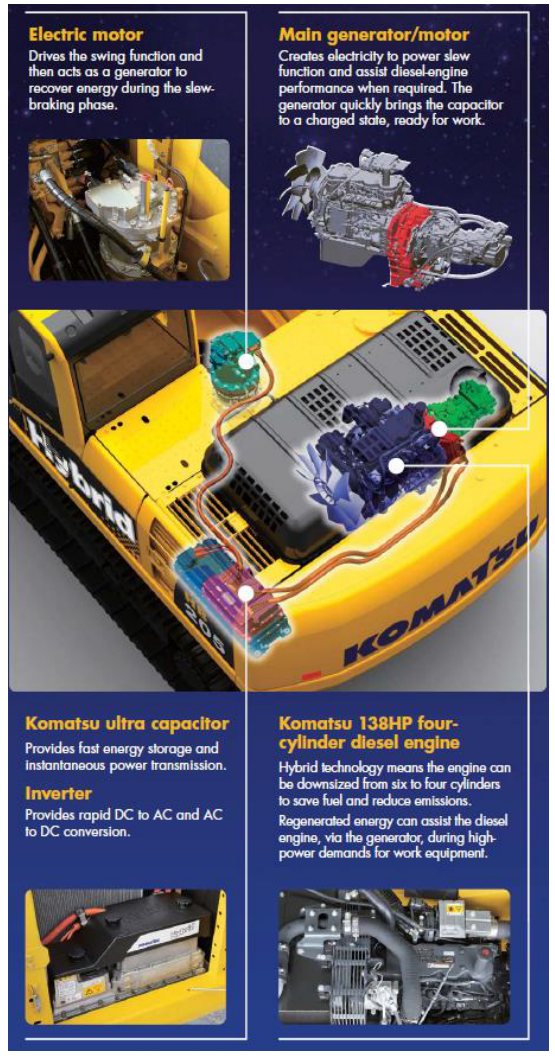
Fig. 35. Komatsu HB205-1 powertrain components [49] Merlo presented in 2013 their 40.7 plug-in hybrid elec- tric vehicle (PHEV). In fully electric mode the energy is supplied from 30 kWh, Li-Ion battery (Fig. 36). In hybrid mode internal combustion engine working at a constant speed supplies energy to the machine drive and charges the battery. In this architecture diesel output can be reduced in a half without the reduction in machine performance. In case of low-load work or idling, machine can work solely electric and reduce fuel consumption and CO emission up 2